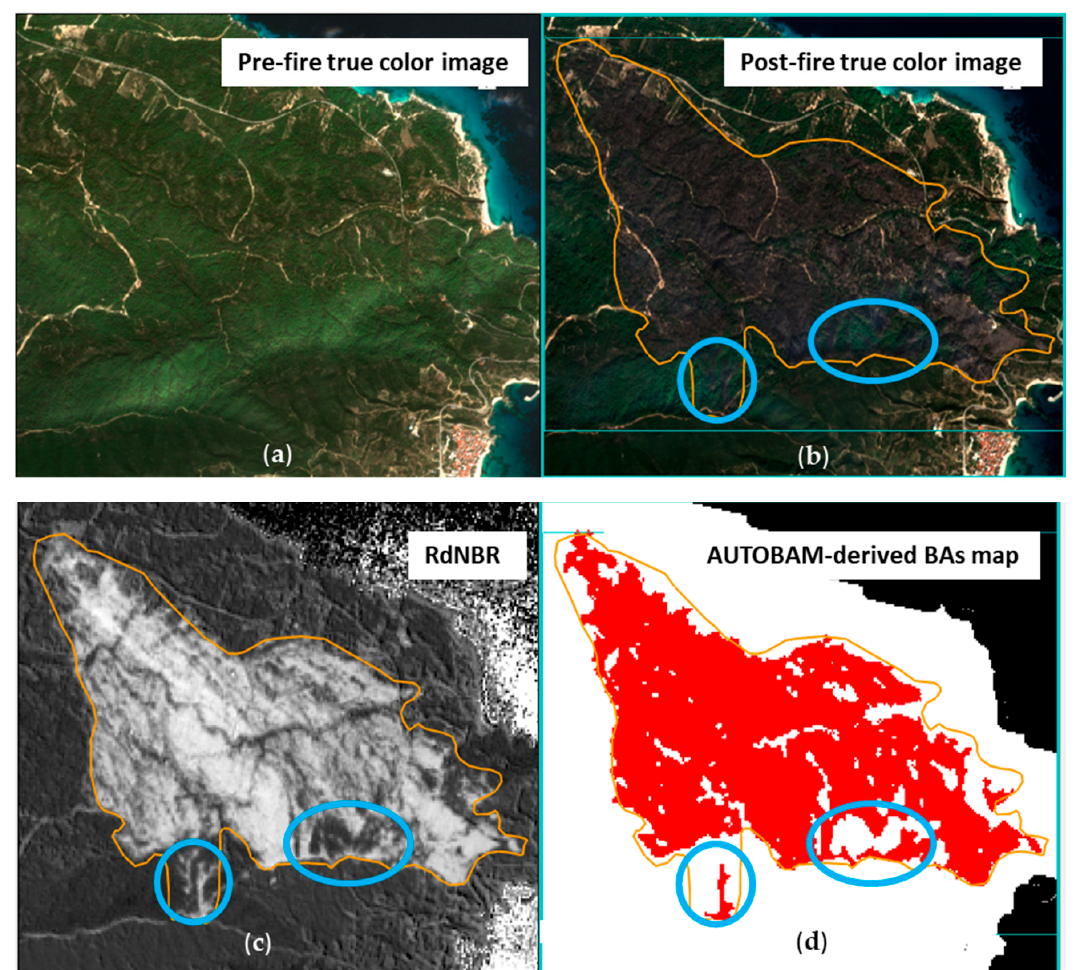
Figure 11 . Zoom on a portion of the area of interest for the Sithonia test case; ( a ) pre-fire true color image; ( b ) post-fire true color image; ( c ) RdNBR map; ( d ) AUTBAM-burned areas map. The orange line delineates the BA according to CEMS, while the blue circles highlight the zones of disagreement between AUTOBAM- and CEMS-derived maps.